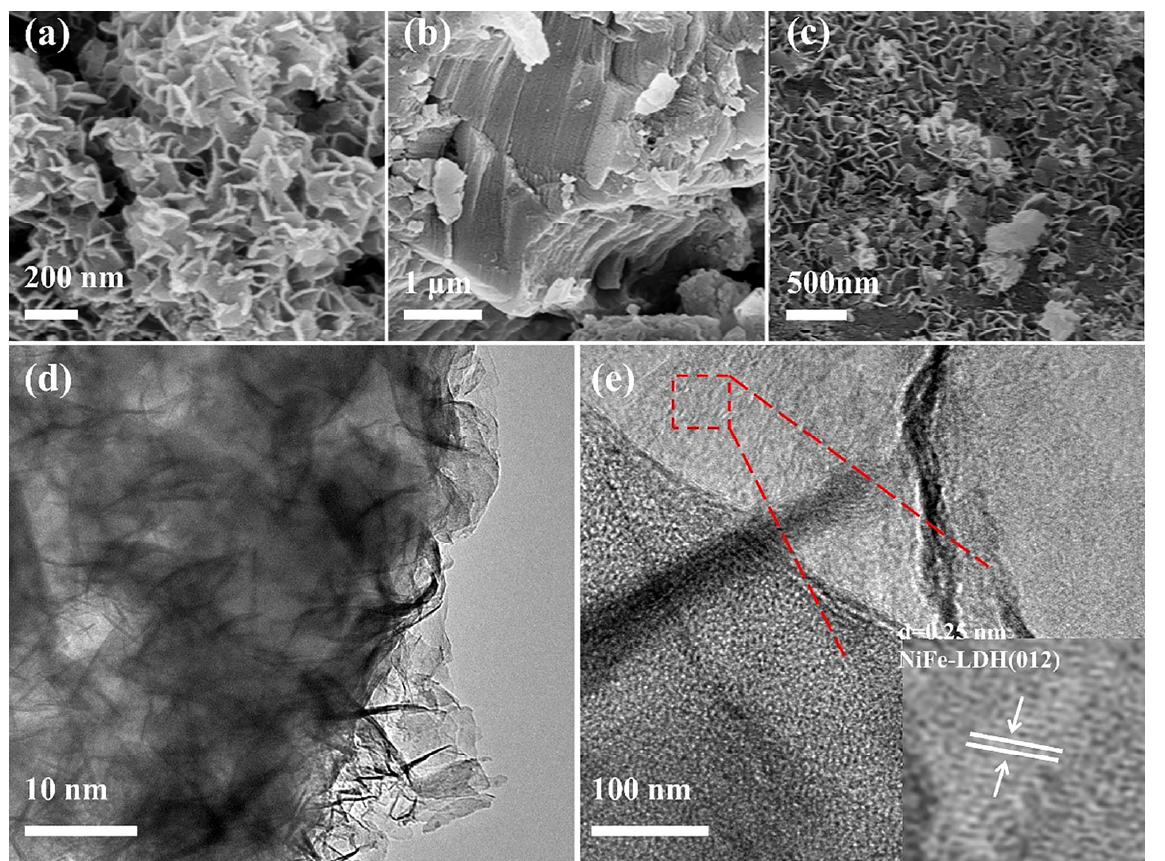
Figure 4. HRSEM images of ( a ) LDH; ( b ) CTF-1; ( c ) LDH/CTF-1-40% . TEM images of ( d , e ) LDH/CTF-1-40%.